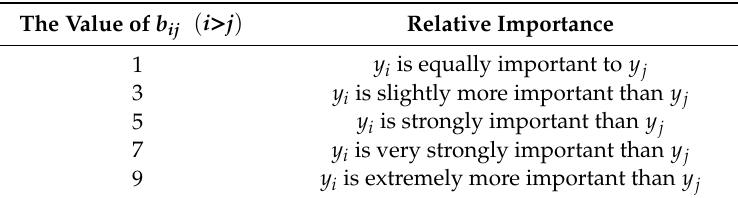
Table 3. The description of the 1–9 scale